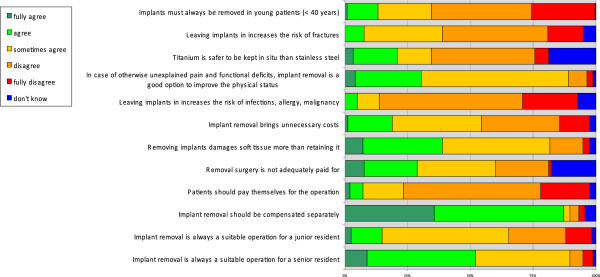
 How would you rate the following statements.